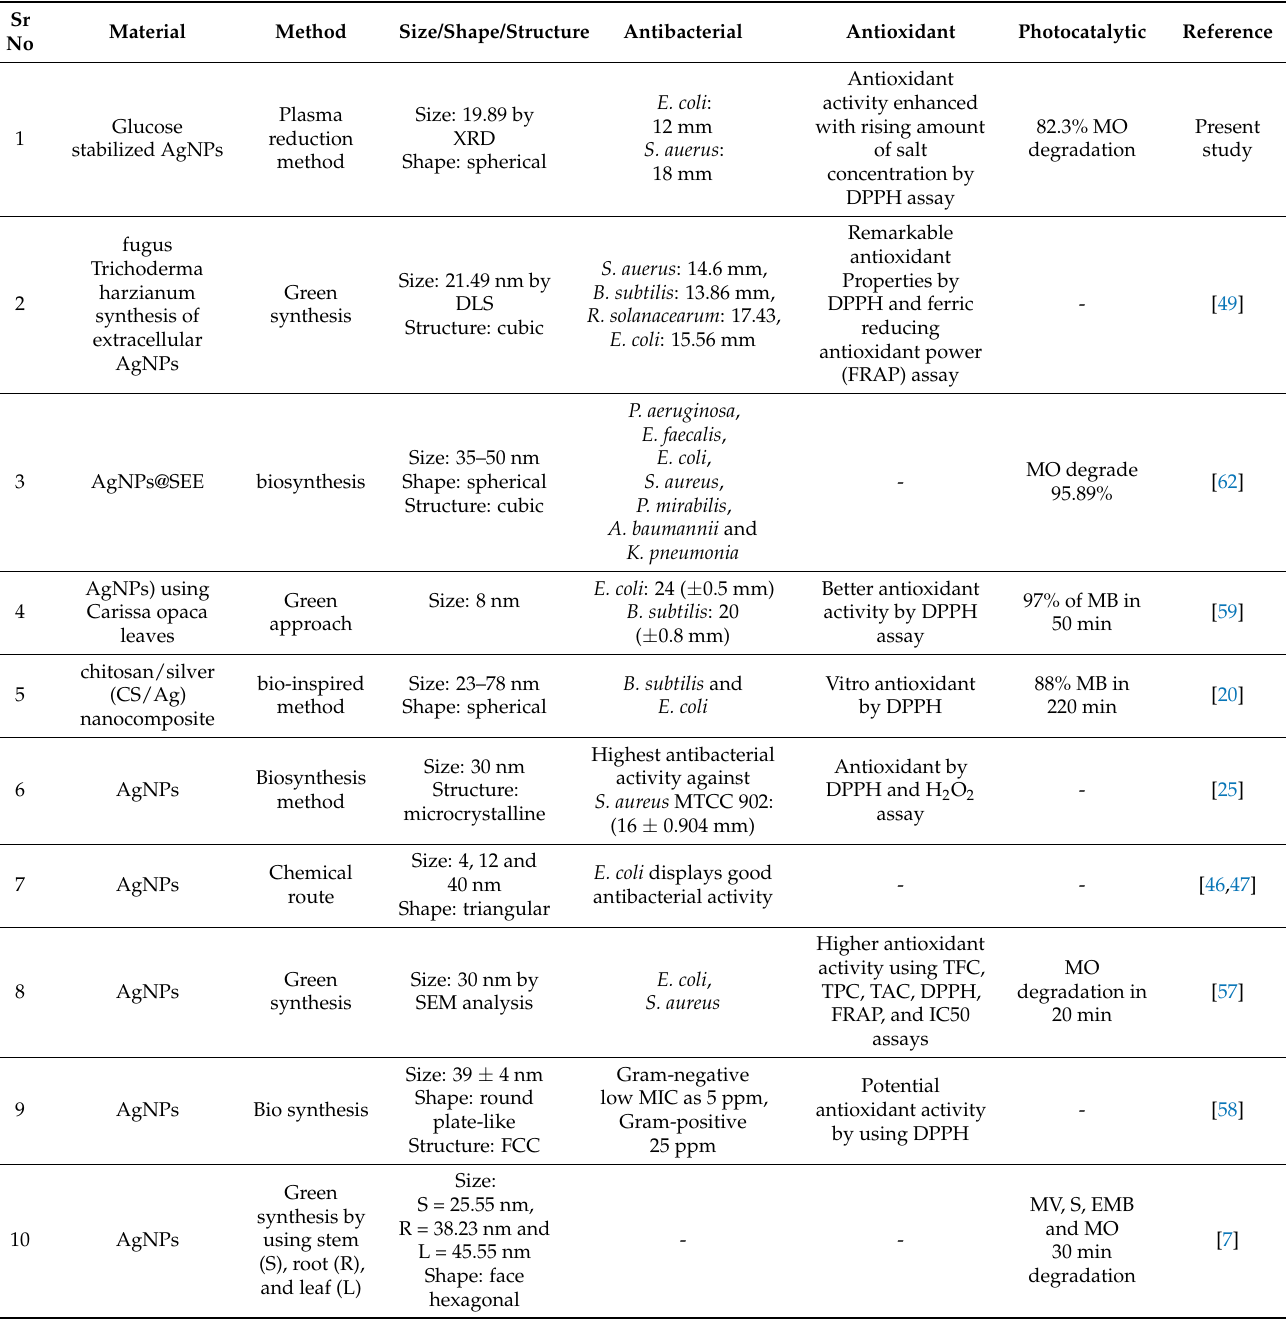
Table 6. Summary of AgNPs-based applications depending on their